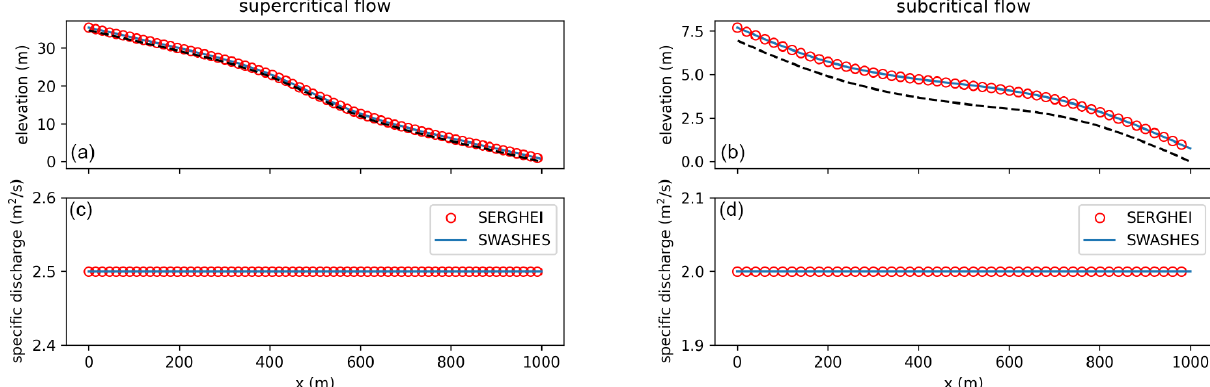
Figure A3. Analytical steady flows: flumes. SERGHEI-SWE captures moving equilibria solutions for a subcritical (a,c) and supercriti- cal (b,d) flow. Note that the solution is stable (no oscillations) and well-balanced (discharge remains constant along the flume).